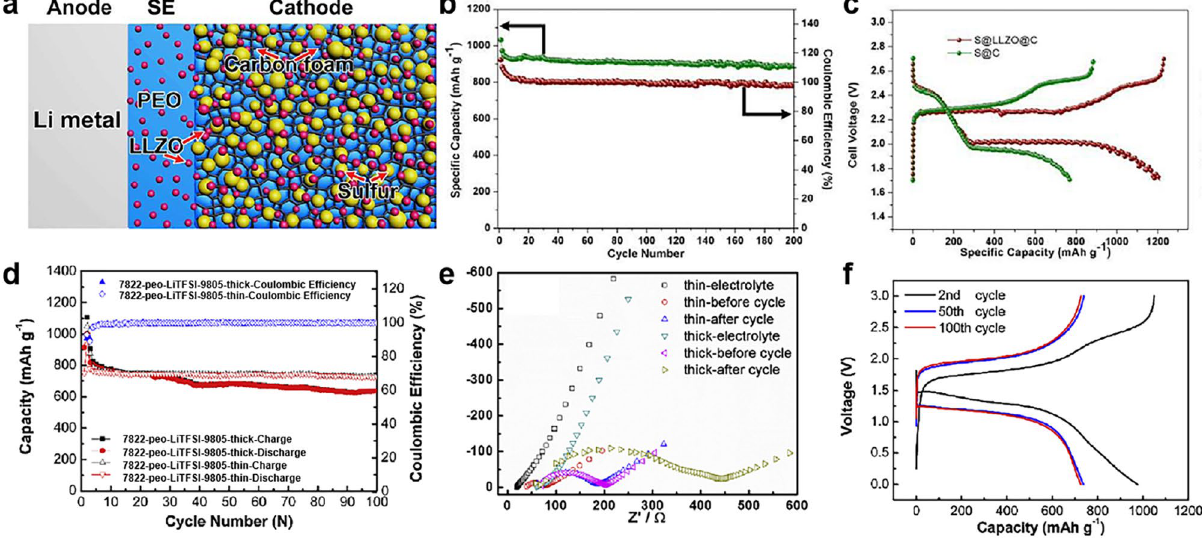
Fig. 15 a Schematic illustration of an SSLSB based on LLZO nanostructures. b Cycling performance and Coulombic efficiency of the S@ LLZO@C cathode with a current density of 0.05 mA cm −2 at 37 °C. c Typical charge/discharge curves of the S@LLZO@C and S@C cathodes with 0.1 mA cm −2 at 50 °C. a – c Reproduced with permission [202]. Copyright 2017, American Chemical Society. d Cycle performance of S-CNT//7822-peo-LiTFSI-9505//Li-In all-solid-state cells. e Nyquist plots for the cells using 80 or 20 mg composite electrolytes before and after the 100th cycle. f The charge–discharge voltage profiles at the 2nd, 50th, and 100th cycles of the cells using 20 mg 7822-peo-LiTFSI-9505 as the electrolyte layers. d – f Reproduced with permission [203]. Copyright 2020,